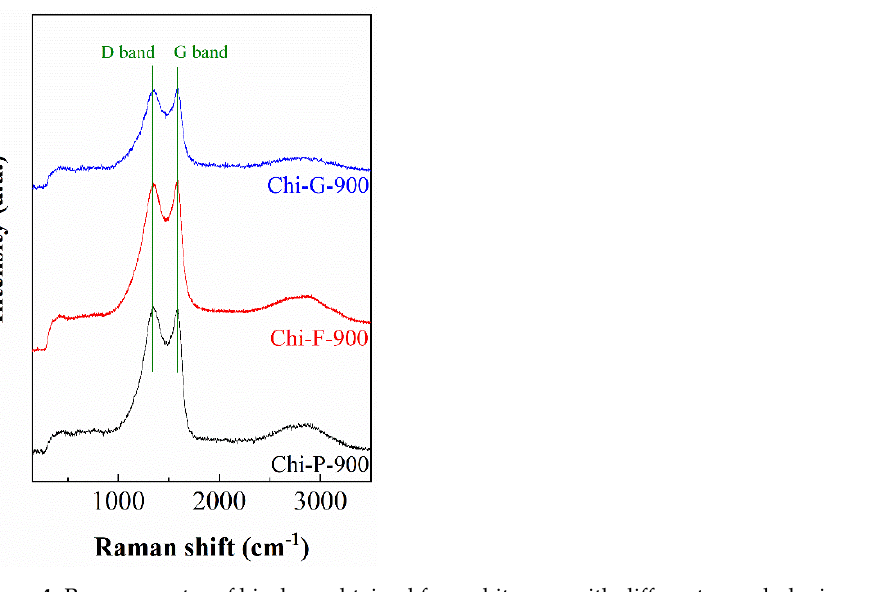
Figure 4. Raman spectra of biochars obtained from chitosans with different morphologies pyrolyzed at 900 °C.